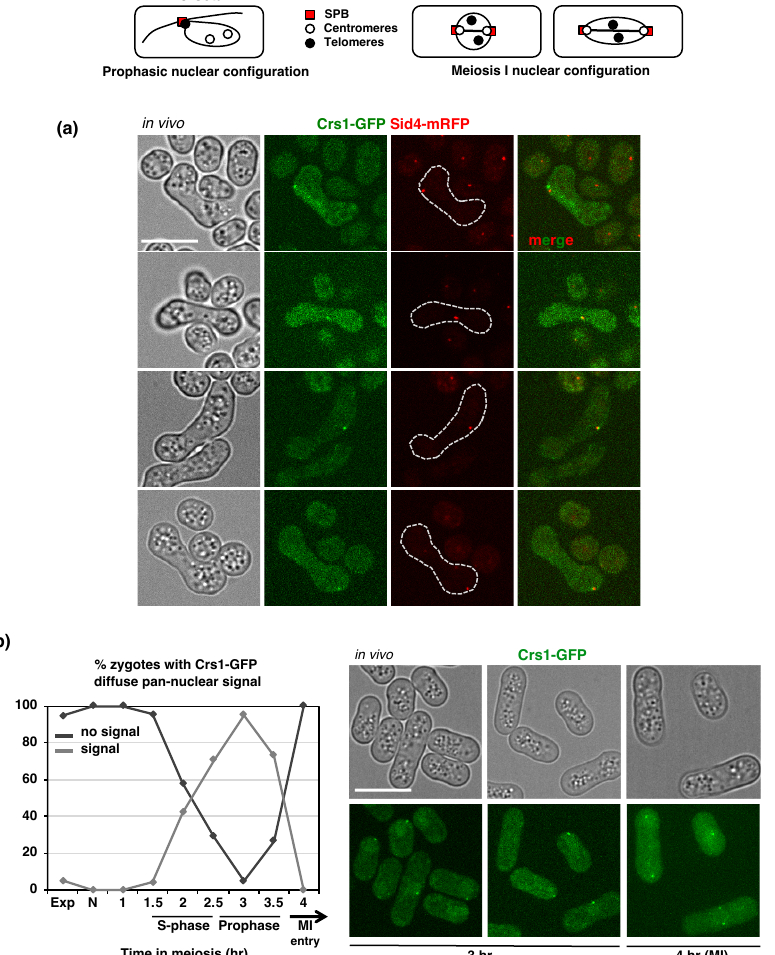
Figure 5. In vivo Crs1-GFP and Sid4-mRFP localization. Top panels: Schematic drawing of SPB, centromeres, and telomeres position during prophase and meiosis I is shown. ( a ) In vivo Crs1-GFP and Sid4-mRFP (SPB component) co-localization in prophase in h 90 zygotes (CMC1076). Single plane bright-field images on the left help to localize the nucleus, which appears as a smooth area more or less stretched depending on the nuclear movement in a rugged context. Notice the Crs1-GFP pan-nuclear diffuse signal in the upper zygote. Crs1-GFP focus and pan-nuclear signal were not always visible in the same focal plane. Crs1-GFP images correspond to single planes, and Sid4-mRFP images correspond to maximal projections of Z sections. In some zygotes, the co-localization was not perfect due to the quite different exposure time to detect the signals (2.5 s for Crs1-GFP and 0.2 s for Sid4-mRFP) and the vigorous nuclear movements at this phase of meiosis. ( b ) Crs1-GFP pan-nuclear signal during synchronous diploid pat1-114 meiosis (CMC1000). Graph represents the percentage (mean of 2 independent experiments) of zygotes with and without Crs1-GFP diffuse pan-nuclear signal during the time course. On the right: Photographs of cells in prophase (3 h after meiotic induction) and meiosis I entry (4 h) are shown. Single plane bright-field images on top help to position the nucleus, which appears as a smooth area often distally located depending on the nuclear movement in a rugged context. Apart from the Crs1-GFP pan-nuclear signal, notice that the Crs1-GFP focus (SPB) is also visible in most of the cells. Pan-nuclear and focus Crs1-GFP signal were not always visible in the same plane. Images correspond to single planes. At least a total of 40 cells were analyzed at each time point, increasing the number of cells to 174–274 from 1.5 to 3.5 h. Scale bar corresponds to 5 µ m in all the images in the